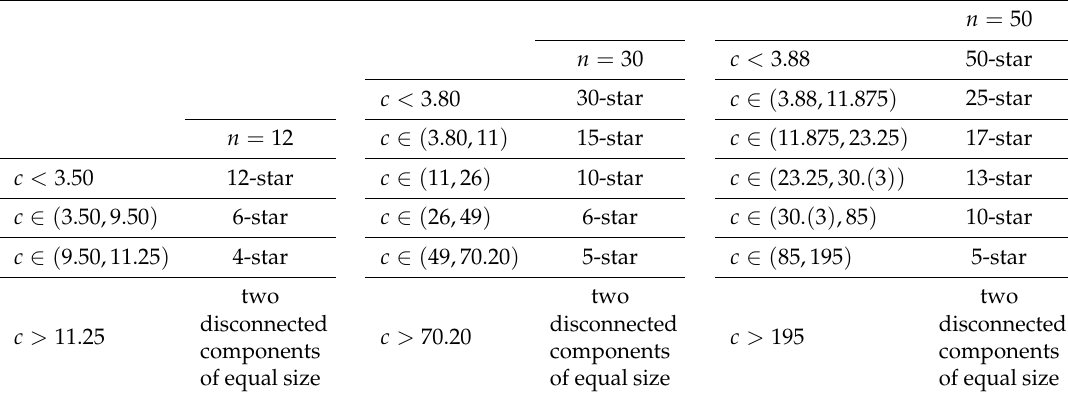
Table 2. Optimal networks for n ∈ { 12,30,50 }